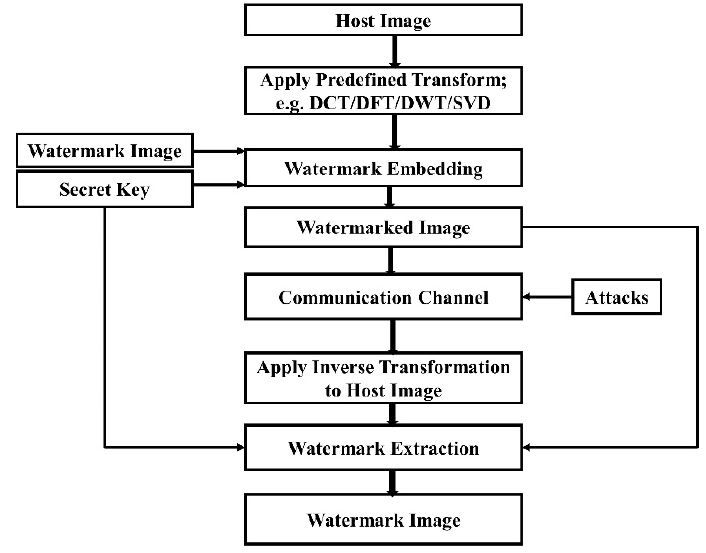
Figure 11. Watermark embedding and extraction in the transform domain.